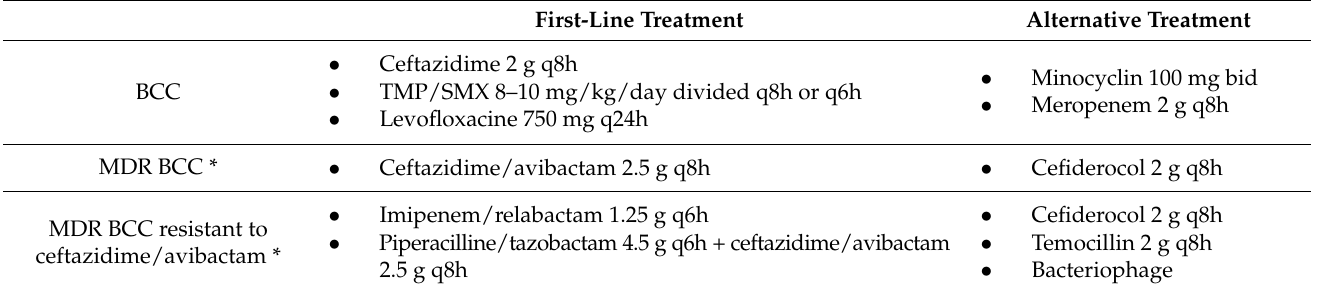
Table 2. Antibiotic treatment option for Burkholderia cepacia complex (BCC)